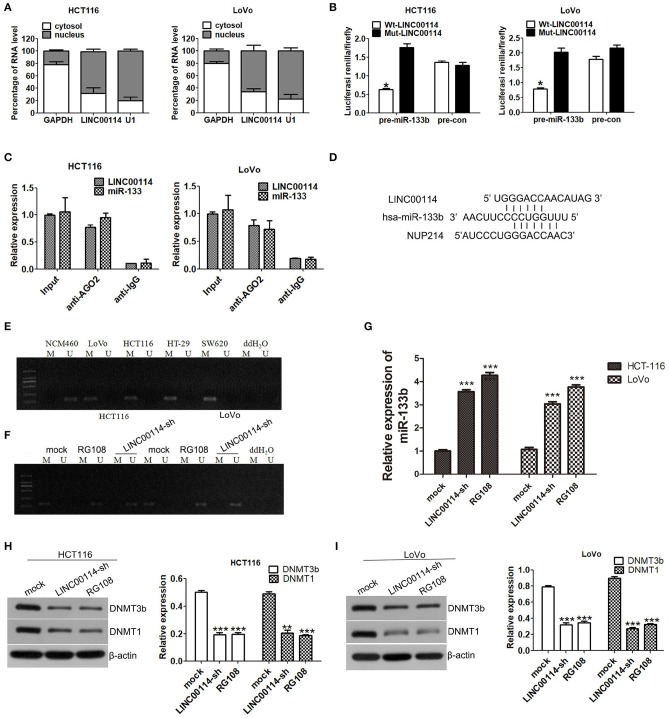
LINC00114 regulates DNA methylation of the miR-133b promoter region. (A) Expression levels of LINC00114 in the nucleus and cytoplasm of HCT116 and LoVo cells. (B) Luciferase activity of cells cotransfected with miR-133b overexpression and control plasmids after LINC00114 overexpression or mutation. (C) RIP assay was used to analyse the binding of LINC00114 to miR-133b. (D) The schematic diagram showed the binding site of miR-133b with LINC00114 and NUP214 mRNA. (E) Methylation detection of miR-133b promoter region in cells. (F)
LINC00114 interference and RG108 treatment reduced the methylation levels of miR-133b promoter region in HCT116 and LoVo cells. (G) miR-133b levels after LINC00114 interference and RG108 treatment reduced the expression of miR-133b in cells. (H,I) Western blotting result showed that DNMT1 and DNMT3B were reduced in LINC00114-silenced or RG108-treated cells. *P < 0.05; **P < 0.01; ***P < 0.001. M, methylation. U, non-methylation.